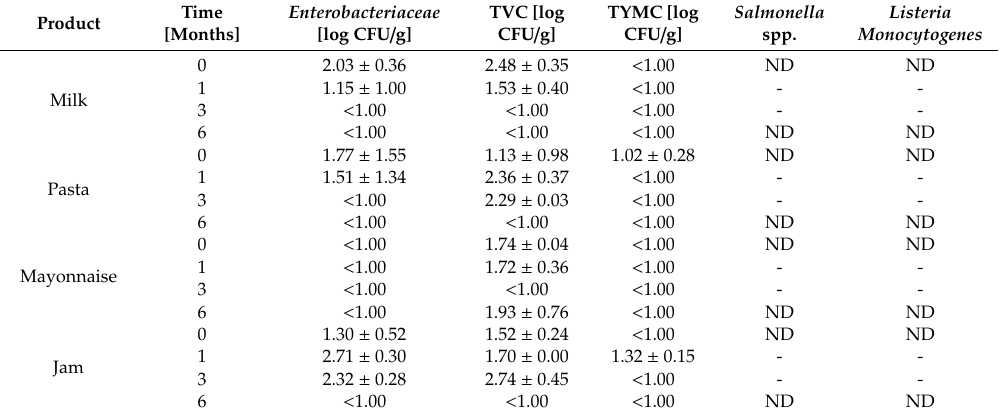
Table 5. The microbiological quality of selected food products on the date of minimum durability (time 0) and 1 month, 3 months and 6 months after the date of minimum durability.